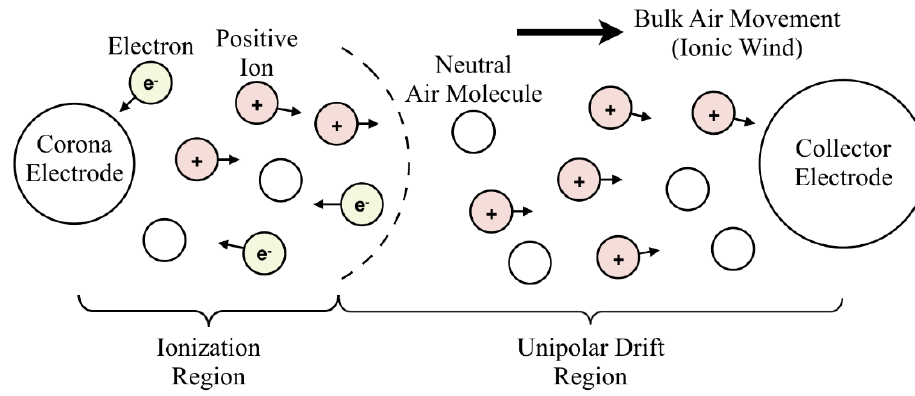
Figure 1. The generation of positive ionic wind. Reproduced with permission from [15].